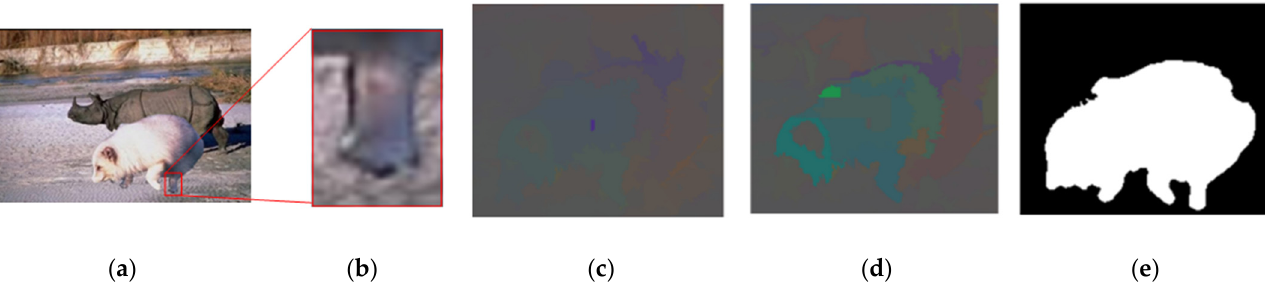
Figure 2. Traces of tampering with image and illumination stream input. ( a ) splicing image. ( b ) blown-up. ( c ) GE. ( d ) IIC. ( e ) Ground Truth.